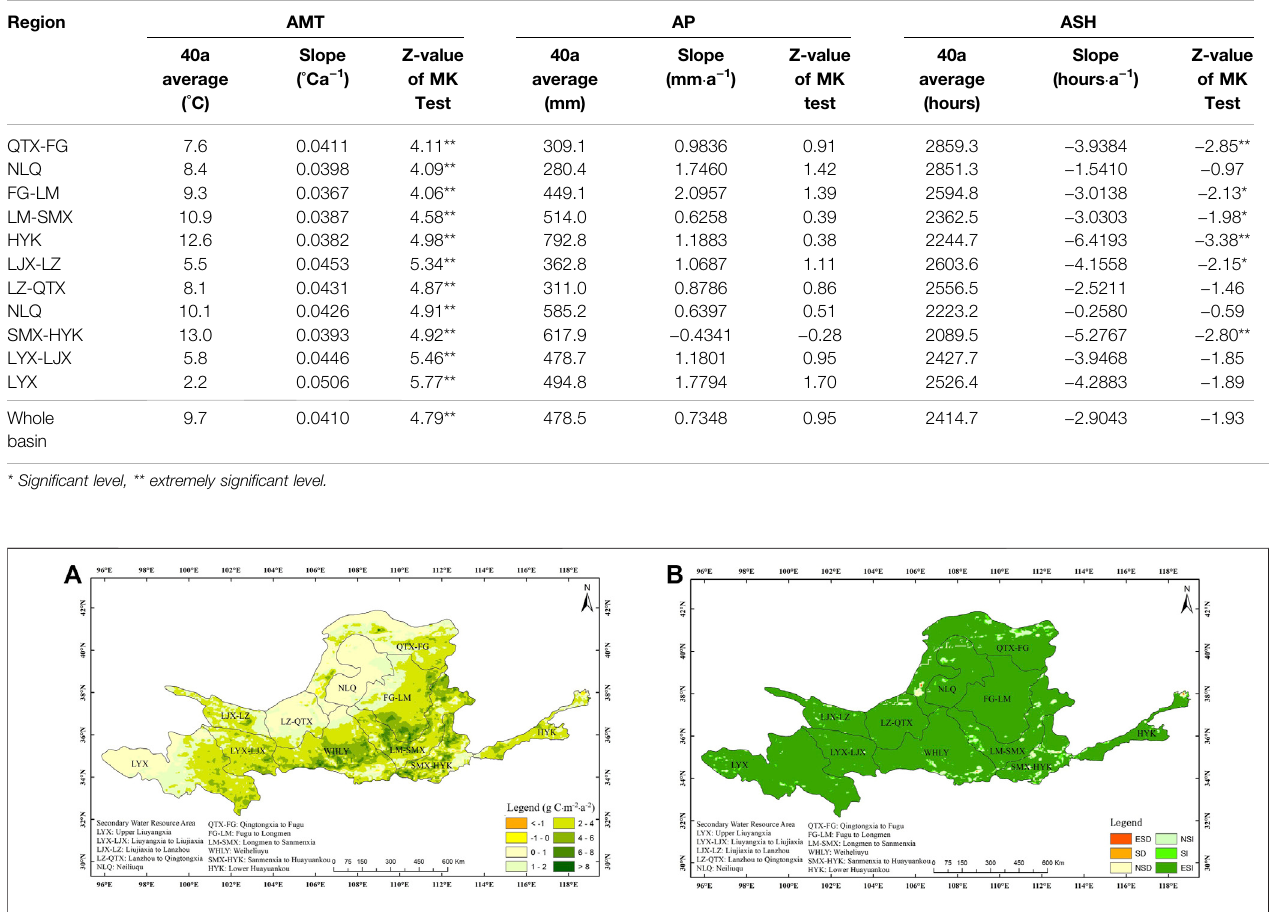
TABLE 1 | Statistical values of climatic factors in secondary water resource areas.